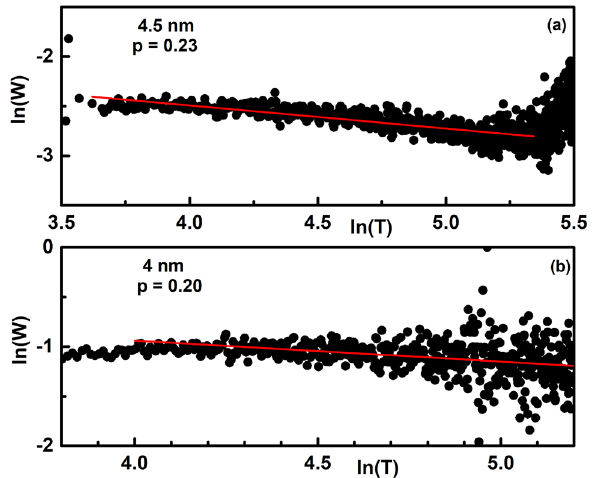
Figure 8. Filled circles denote the lnW variation of lnT in ( a ) 4.5 nm and ( b ) 4 nm thin film. Red solid lines in each panel is a straight fit to the respective data.